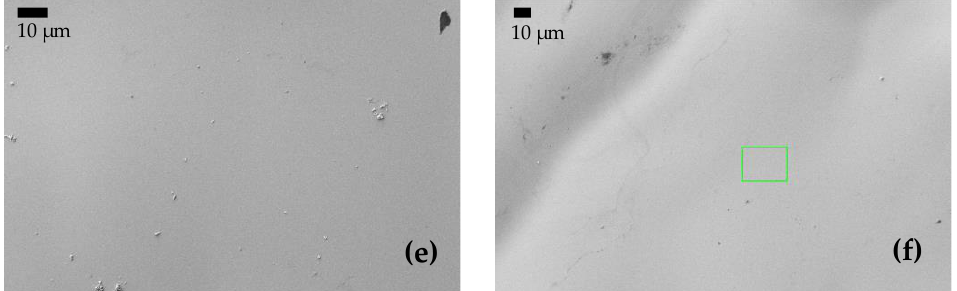
Figure 7. ( a , c , e ) BSE images of the surface of samples A, AB20, and AB10Si10, respectively, before immersion in 3 wt.% NaCl at room temperature. ( b , d , f ) BSE images of A, AB20, and AB10Si10, respectively, after immersion.